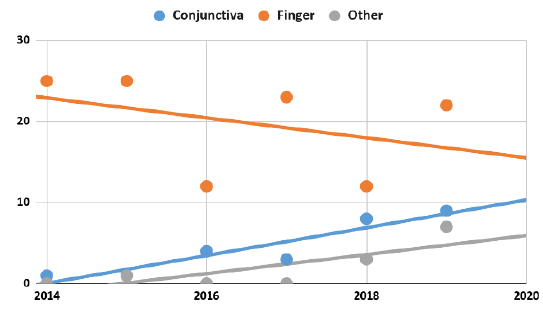
Figure 12. Device Type over Years.